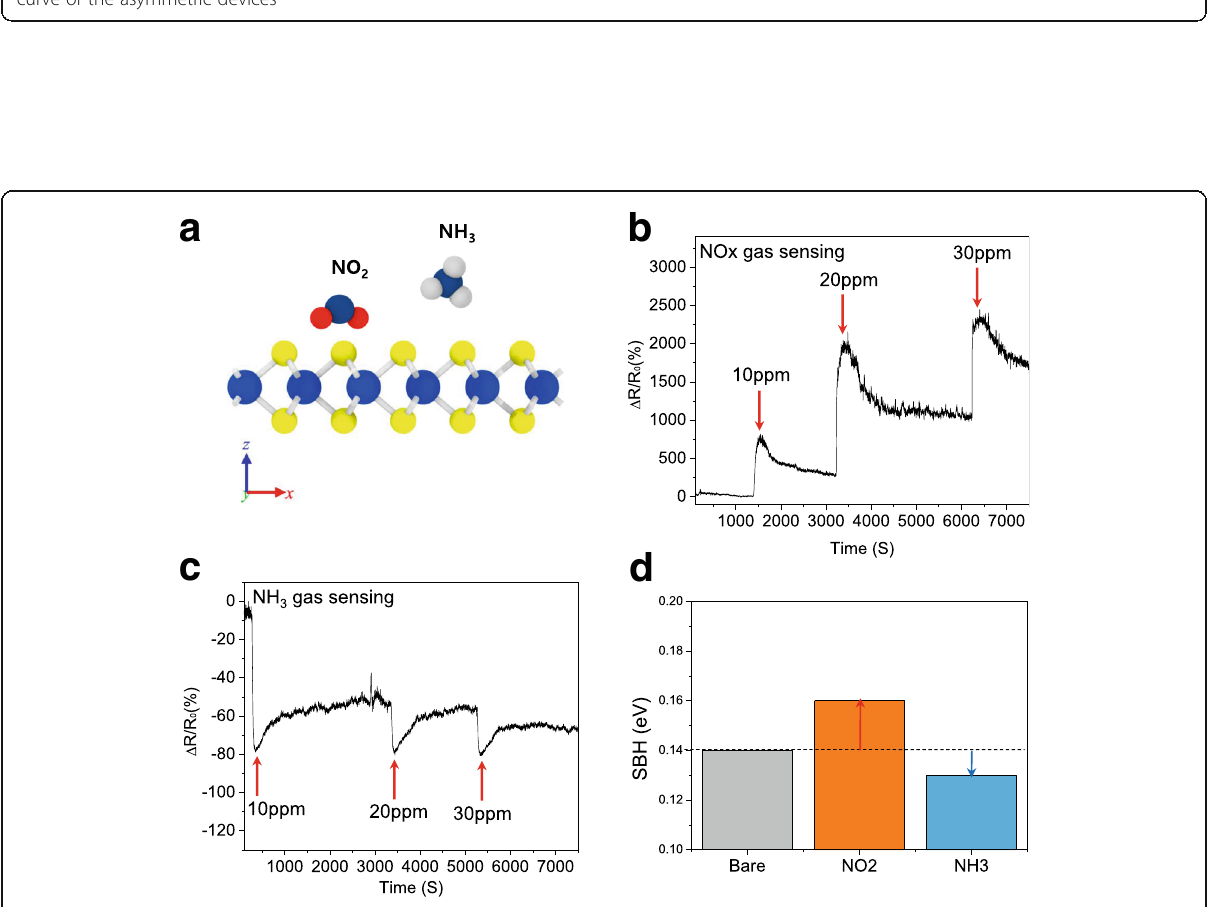
Fig. 5 a Schematic diagram of MoS 2 and the gas molecules, which were used for simulation. b , c The resistance changes of the MoS 2 Schottky diode upon NO x and NH 3 exposure, respectively. d Theoretically calculated SBH of the MoS 2 /metal interface under ambient and gas exposure conditions (NO, NO 2 , and NH 3